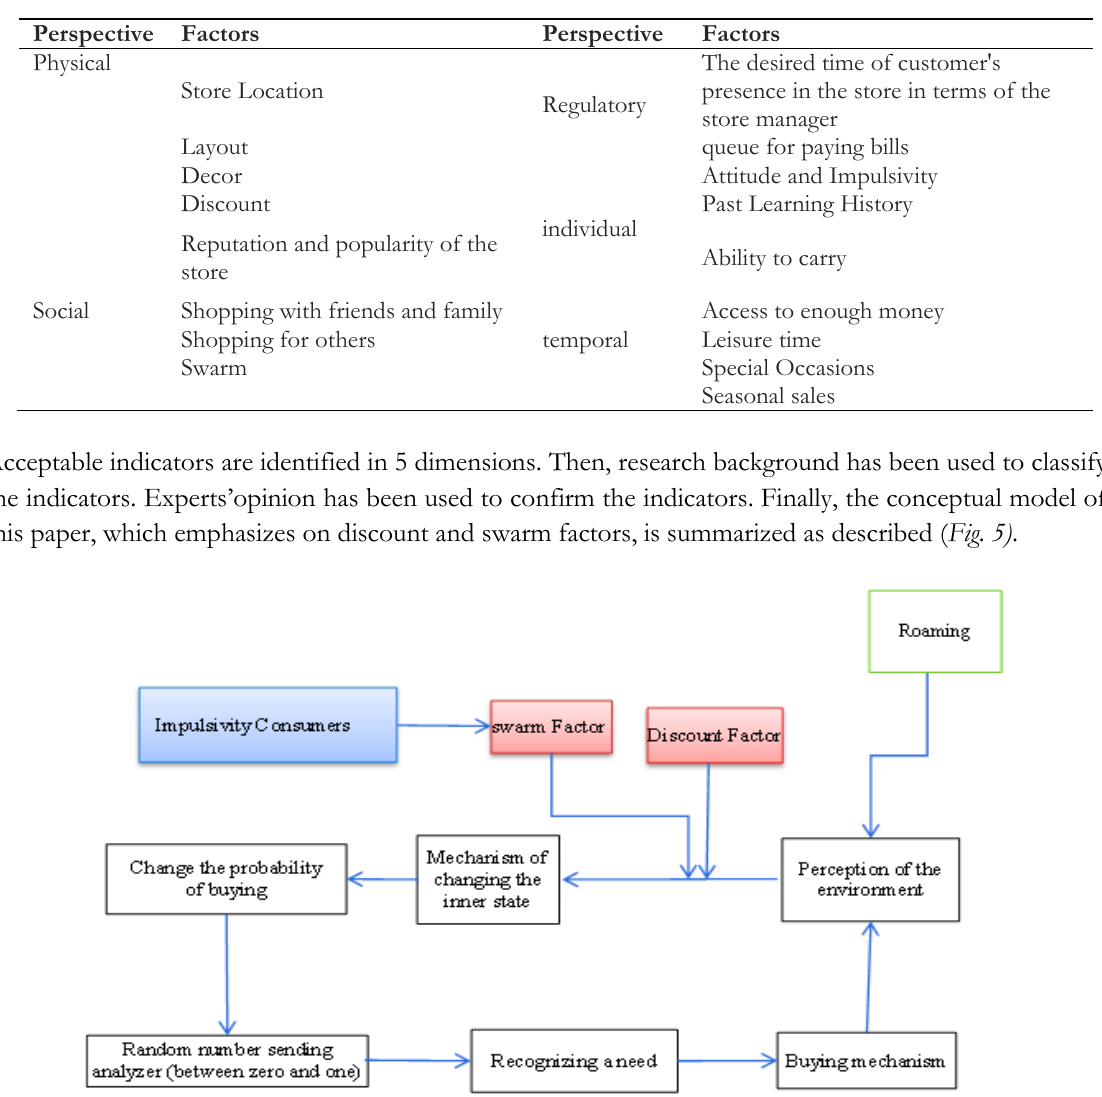
Table 4. Identified IB factors resulting from fuzzy screening (source: research-findings).